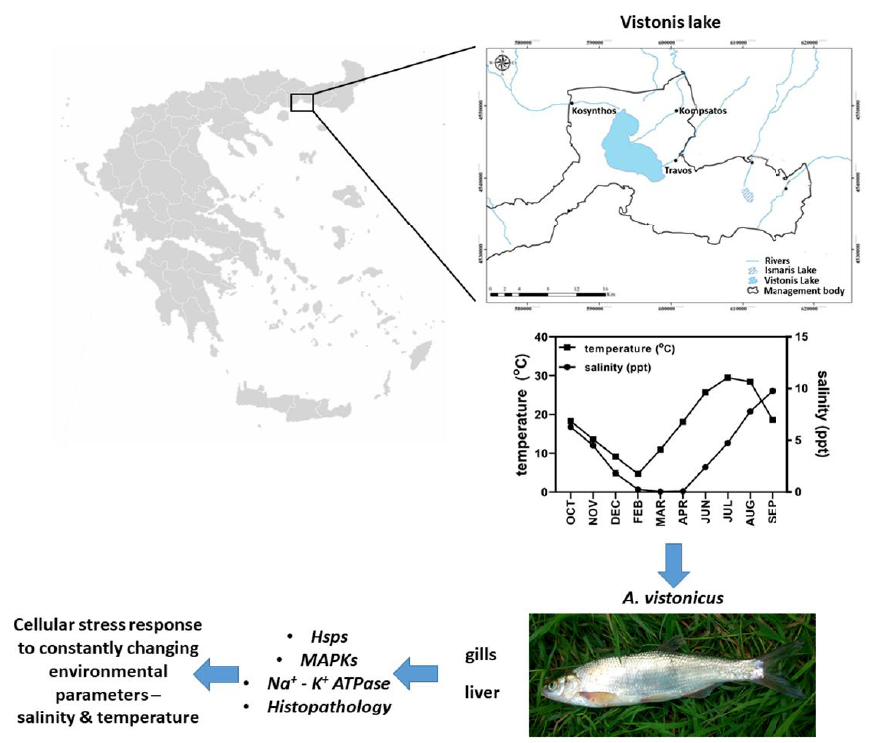
Figure 8. Summarized model of cellular stress responses of the freshwater fish species Alburnus vistonicus in Vistonis Lake (Northern Greece) under the seasonal variation of the physico-chemical